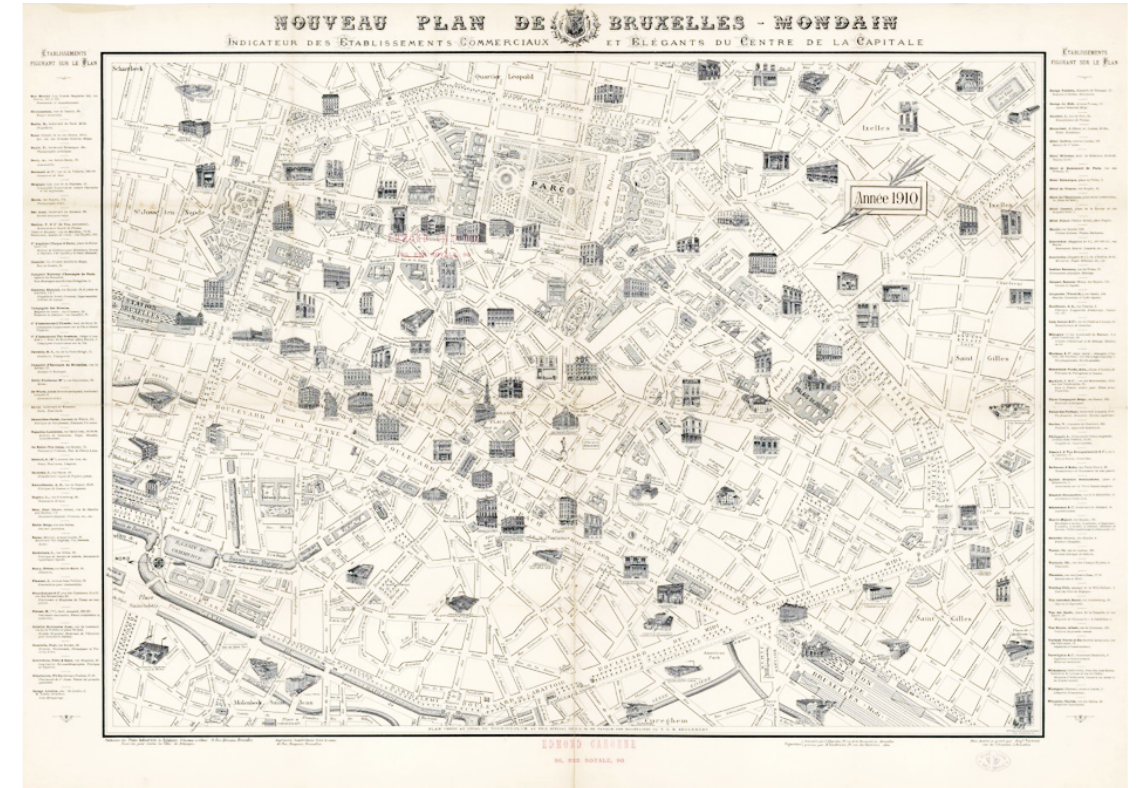
Figure 5. Nouveau Plan de Bruxelles Mondain (Verwest et al., 1910b). Courtesy of the Musée royal de l’Armée (cartes, Bruxelles 60).